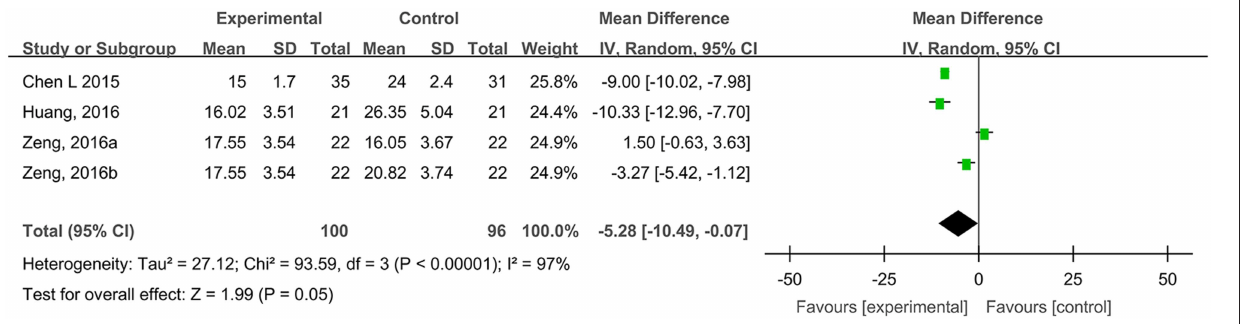
Frontiers in Bioengineering and Biotechnology |